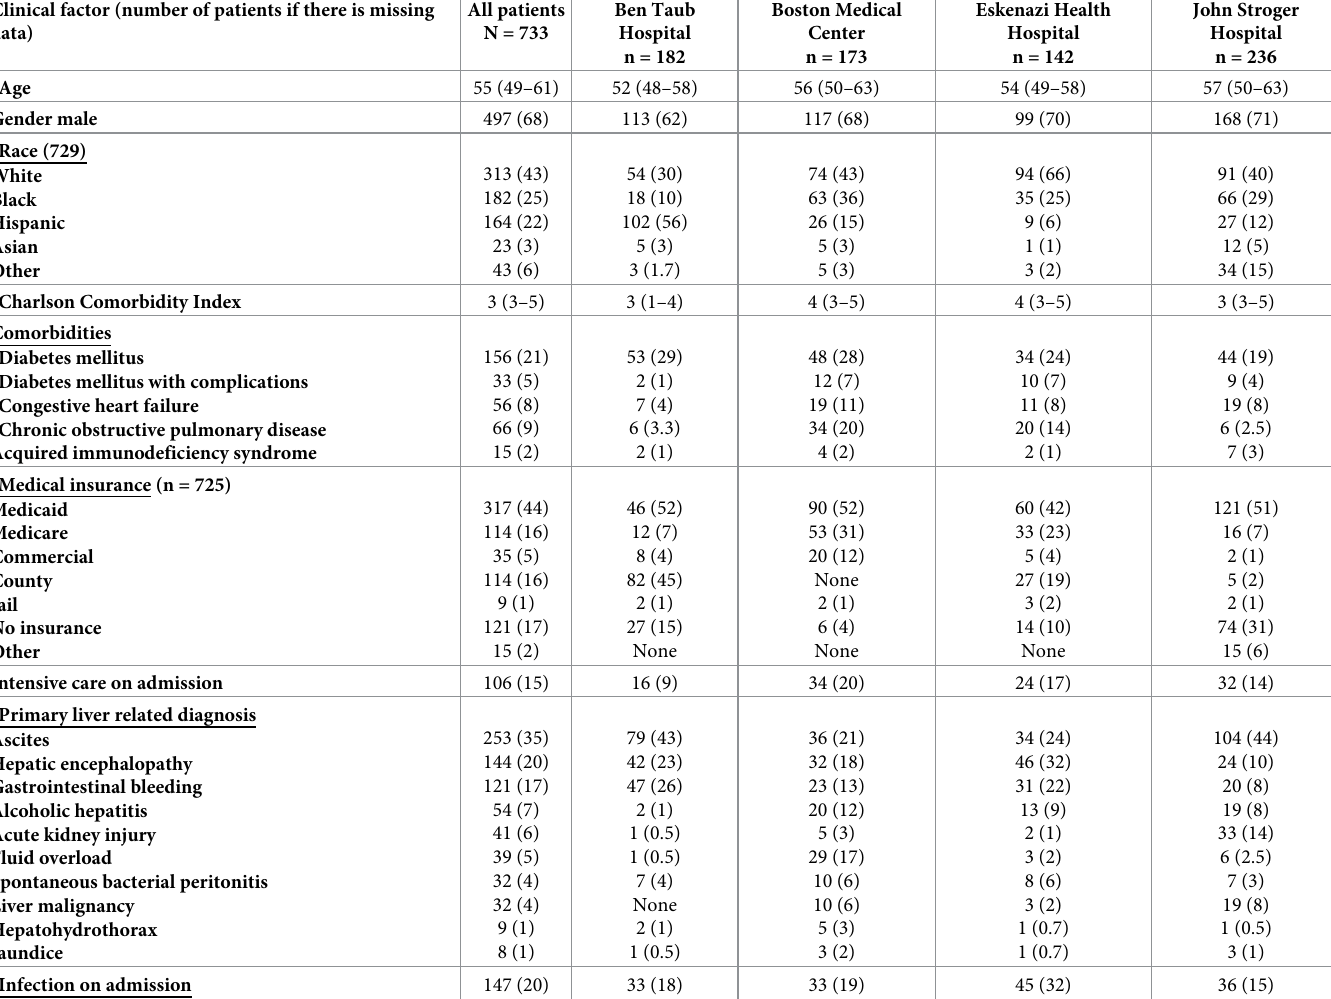
Table 1. Demographics, insurance, selected comorbidities, primary liver related diagnosis and admission disposition in the study cohort and in 733 patients hospi- talized at the respective study centers. Data are reported as number (percent) or median value (interquartile range). Clinical factor (number of patients if there is missing